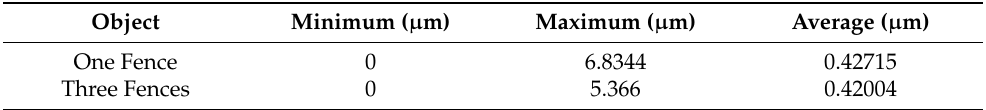
Table 6. Deformation Values when Increasing the Vertical Load on the Posterior Jaw to 150 N while Decreasing the Load on the Anterior Jaw to 50 N.